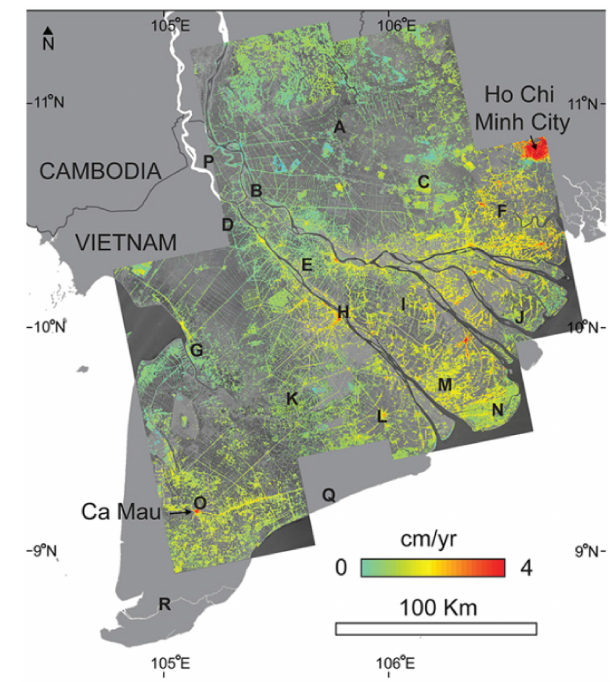
Figure 1. InSAR-based subsidence rates measured between 2006 and 2010 in the Mekong Delta. Locations of monitoring wells are marked by letters. Data © JAXA, METI 2011 (Erban et al.,